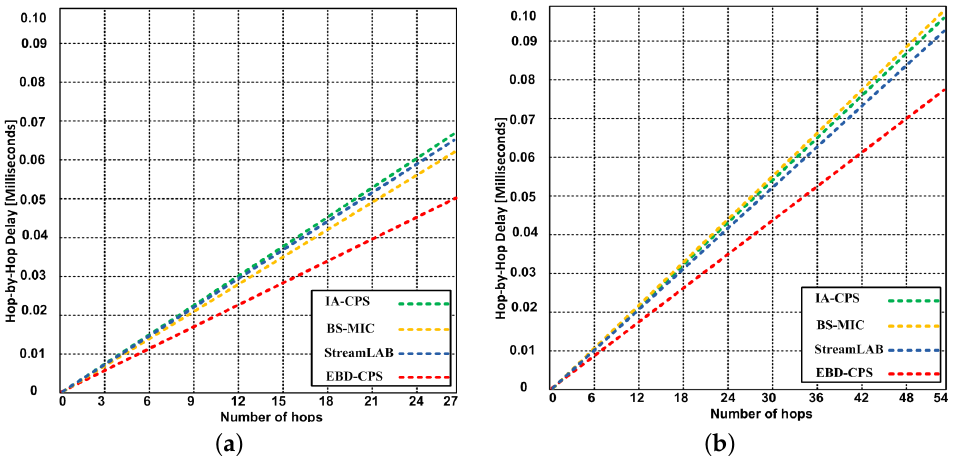
Figure 5. ( a ) Number of hops versus the required amount of time for the proposed EDB-CPS and the contending models, IA-CPS, BS-MIC, and StreamLAB, with a maximum of 27 hops. ( b ) Number of hops versus the required amount of time for the proposed EDB-CPS and the contending models, IA-CPS, BS-MIC, and StreamLAB, with a maximum of 54